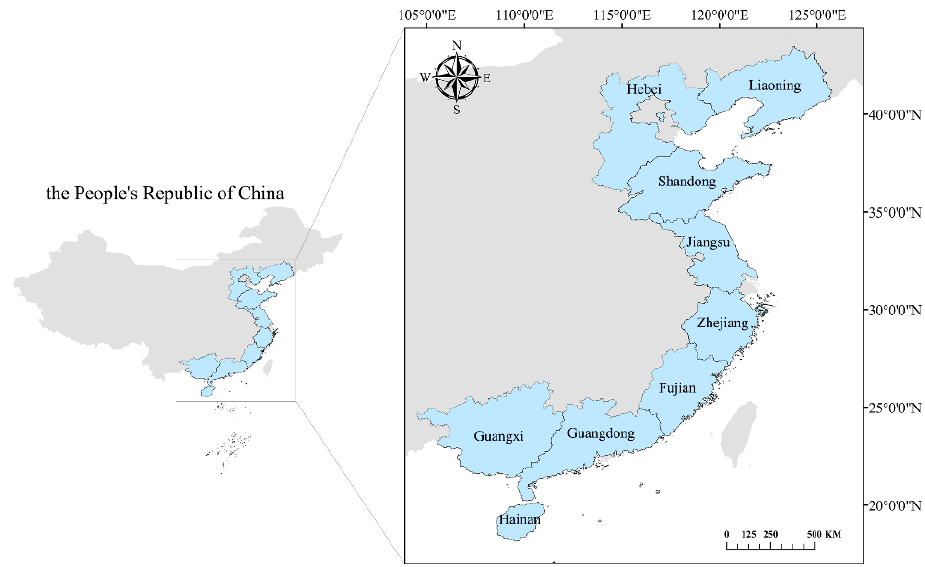
Figure 1. Map of China’s coastal areas. The shellfish and algae mariculture production in Hong Kong, Macao, Taiwan Province, Shanghai, and Tianjin were not included due to data availability and validity concerns.